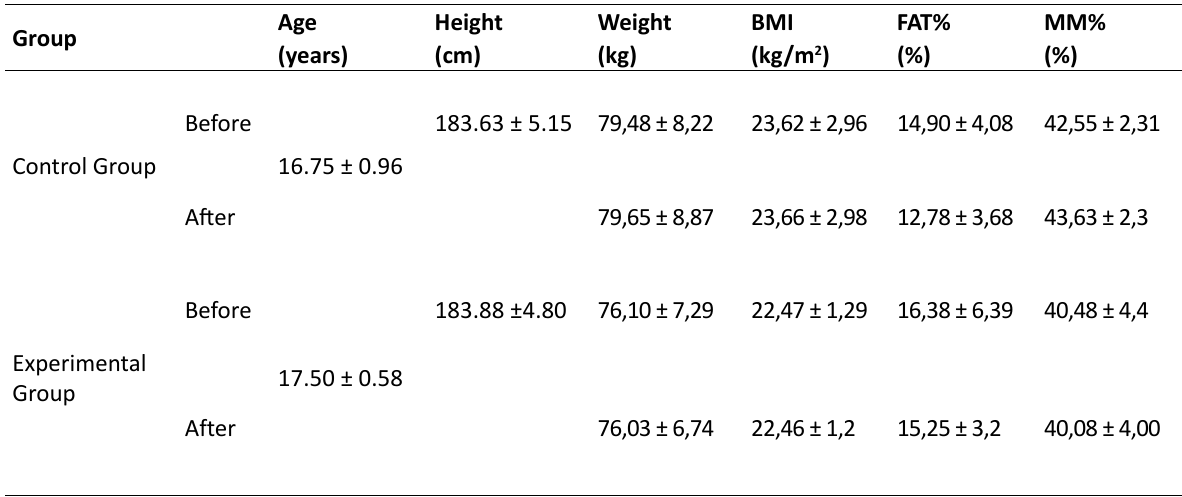
Table 2. Anthropometric data of the athletes from the control and experimental groups.